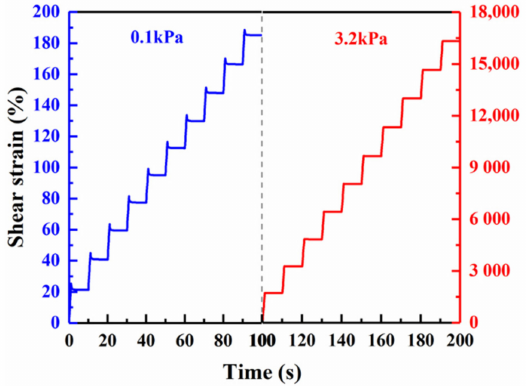
Figure 3. Diagram of multiple stress creep recovery